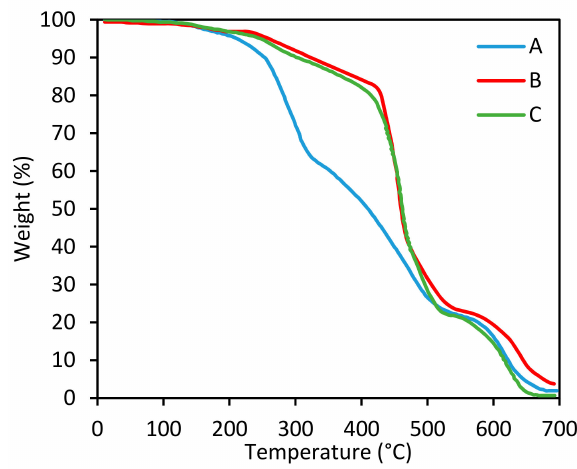
Figure 7. TGA curves of the various samples at a heating rate of 10 ◦ C/min.